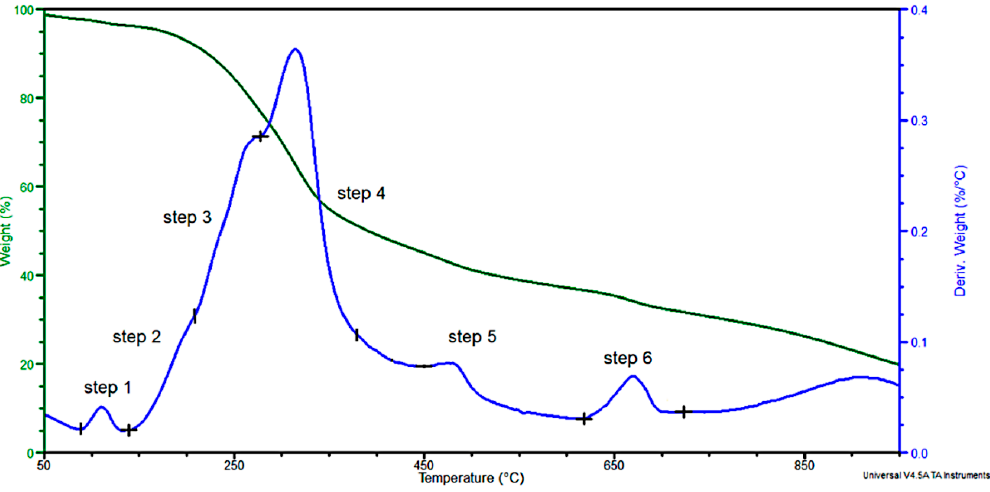
Figure 2. Thermograms of hop residue.